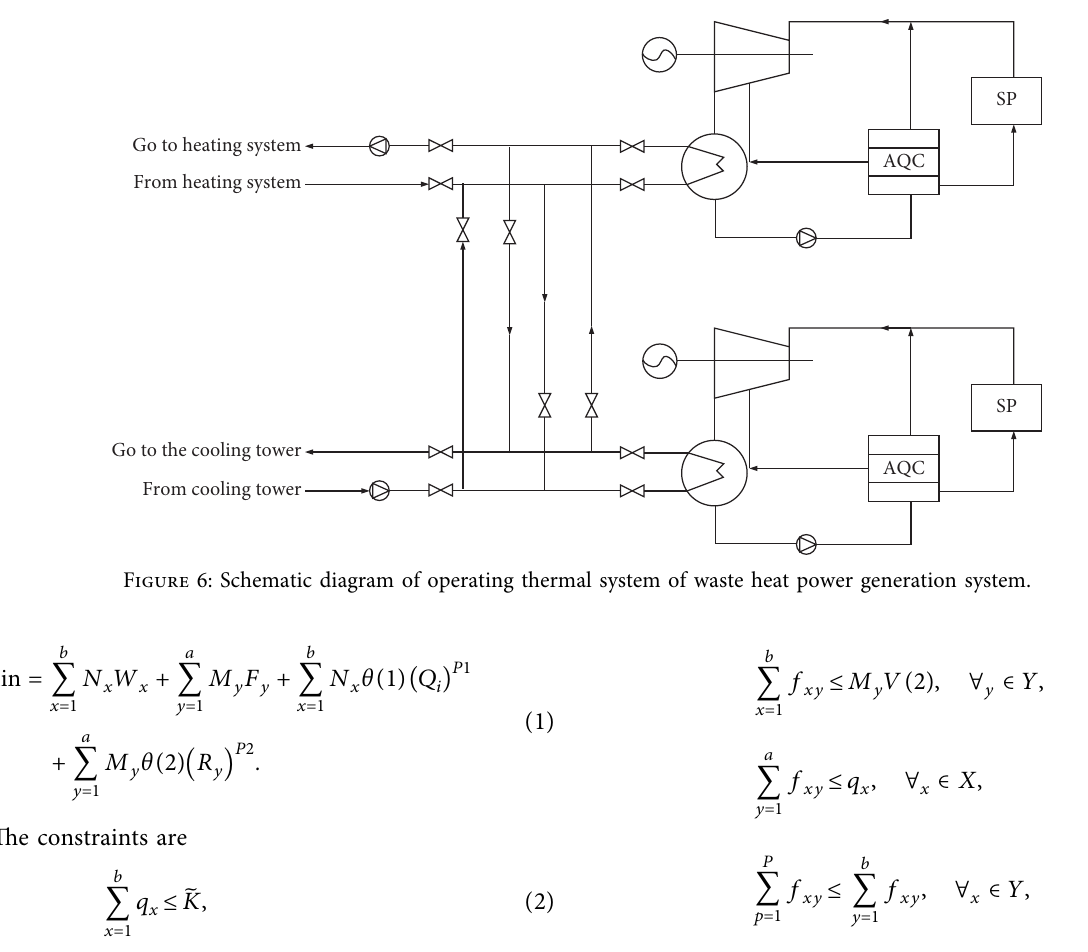
Figure 5: Schematic diagram of waste heat hot water